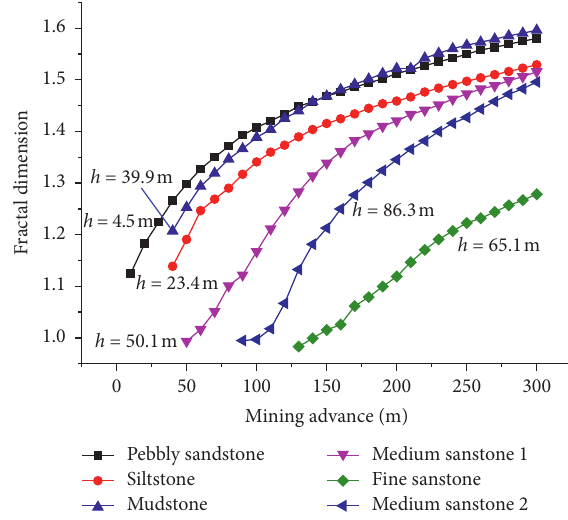
Figure 14: Fractal dimension of all the fractures in each stratum with mining face advance based on the horizontal section (1) In terms of the number of fractures, more fractures were generated in the lower strata than in the higher strata. In addition, a fracture could more easily develop and expand in the soft rock (mudstone) than in the hard rock (fine sandstone).